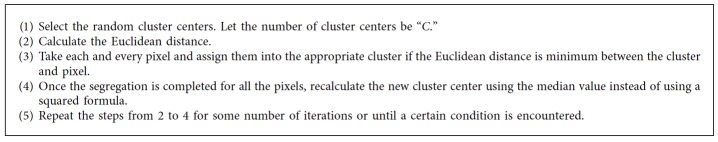

k-Median clustering.